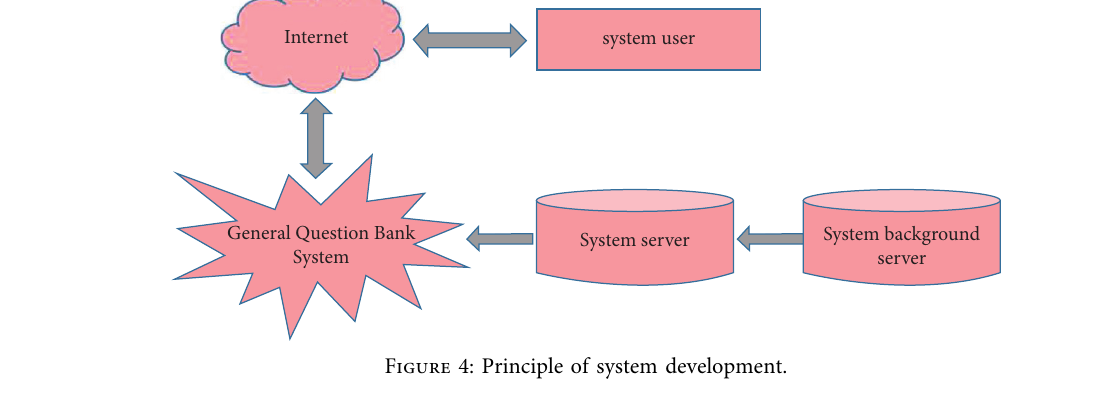
Figure 4: Principle of system development.